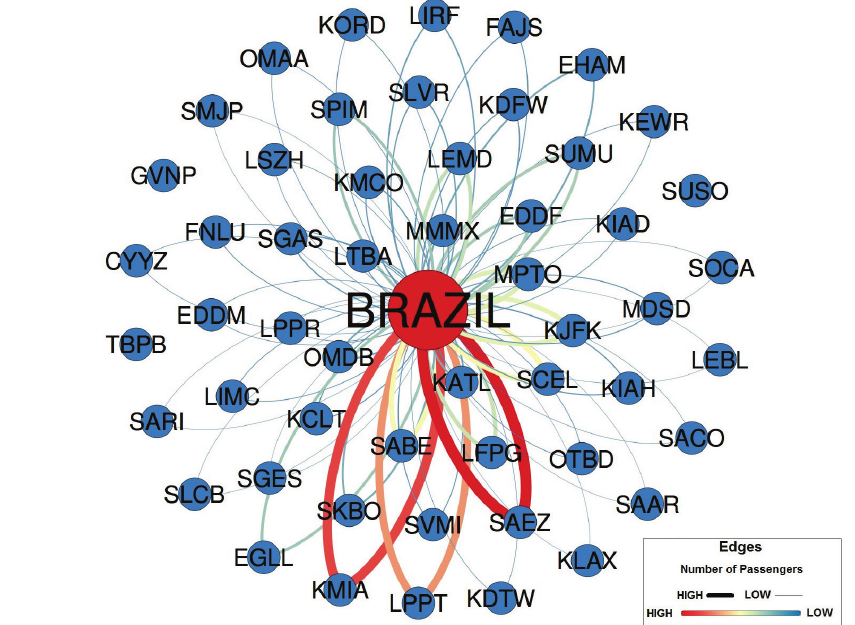
Figure 8 - Brazilian Connections from/to Worldwide. For interpretation of the refe- rences to color in this figure, the reader is referred to the web version of this article.